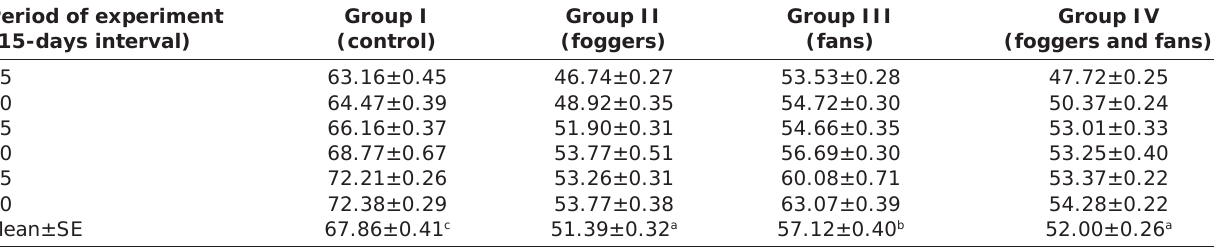
Table-8: Effect of microclimate alteration on pulse rate (beats/min) in Murrah buffaloes during summer. Period of experiment (15-days interval)